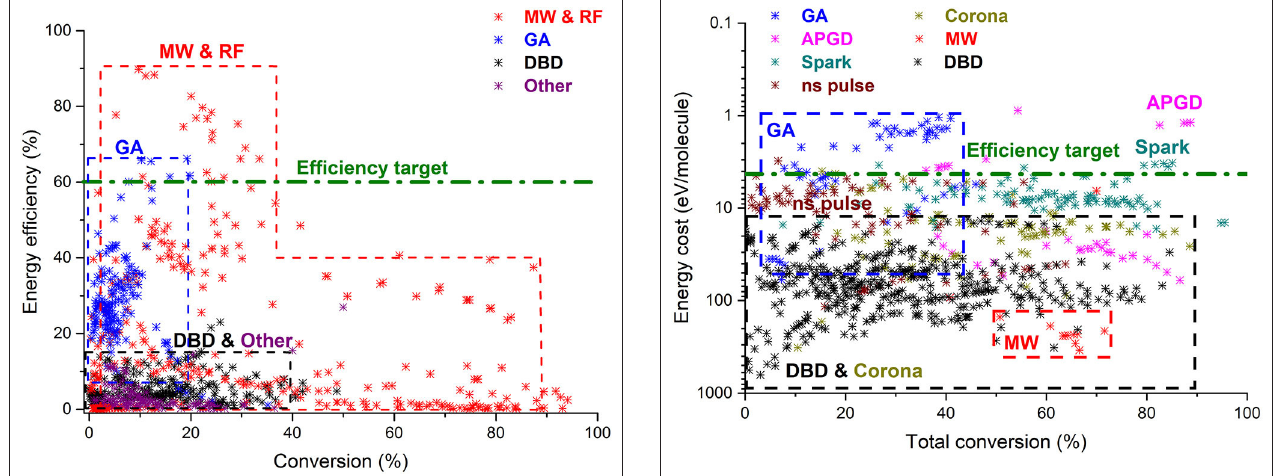
FIGURE 2 | Comparison of all data from literature for CO 2 splitting in different plasma reactors, illustrating the energy efficiency as a function of conversion. The 60% efficiency target is also indicated. Adopted from Snoeckx and Bogaerts (2017) with permission.